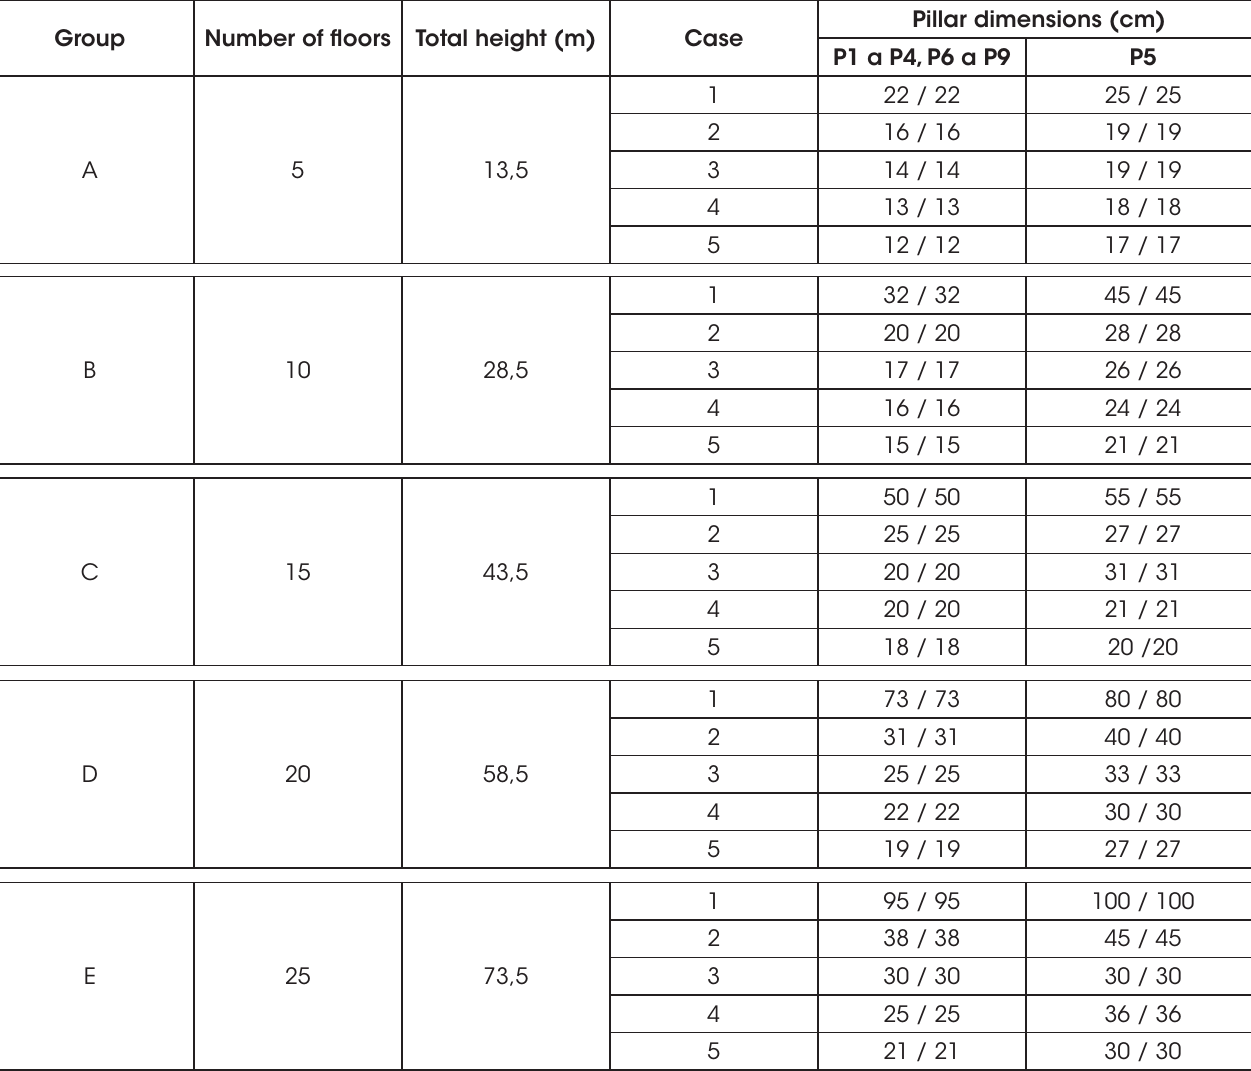
Characteristics of the idealized structures Group